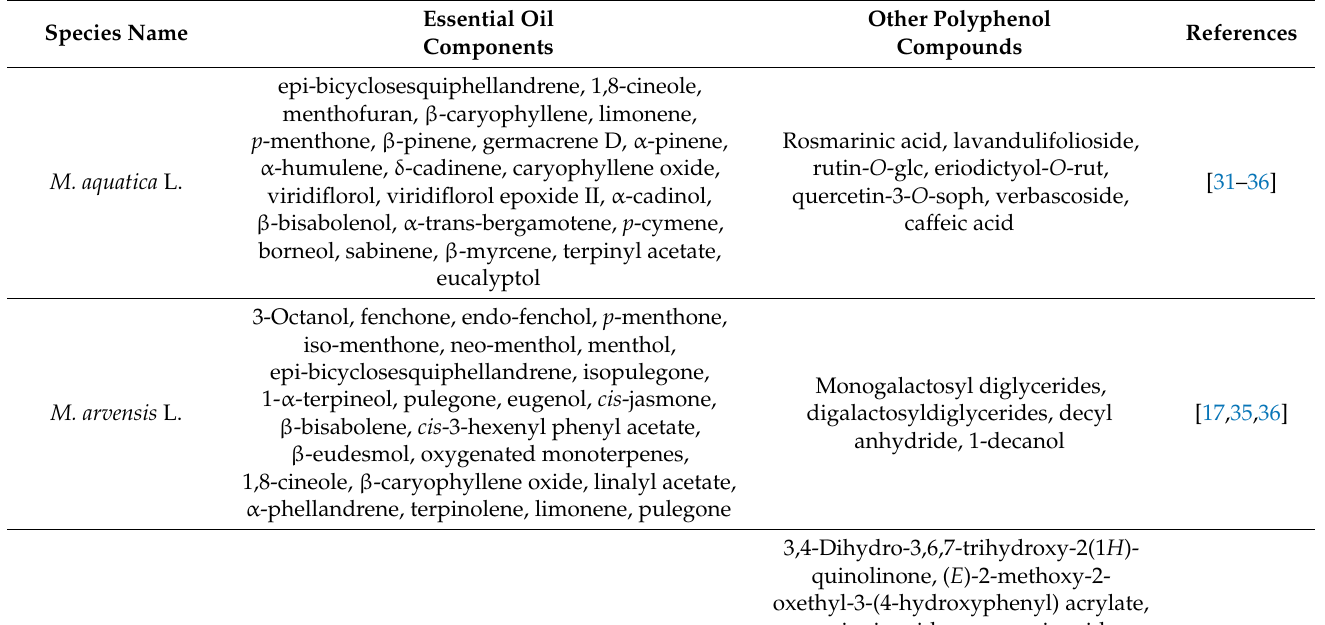
Table 2. Main chemical compounds isolated from different Mentha